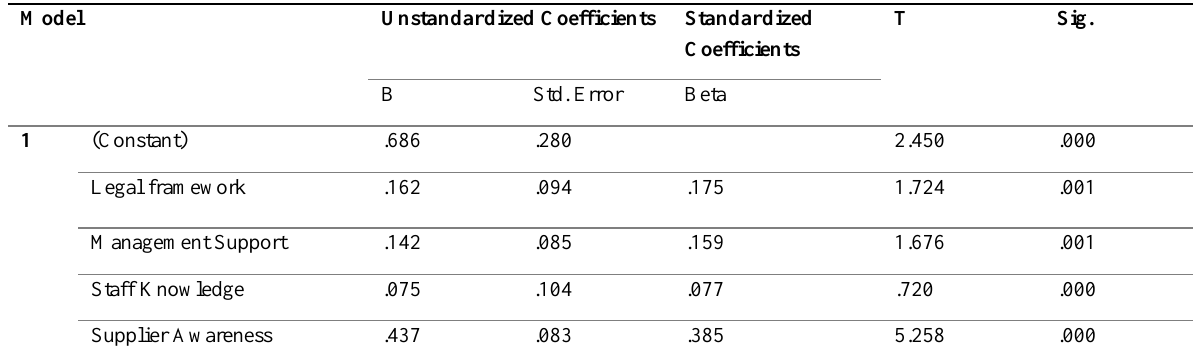
Table 11: Regression Model